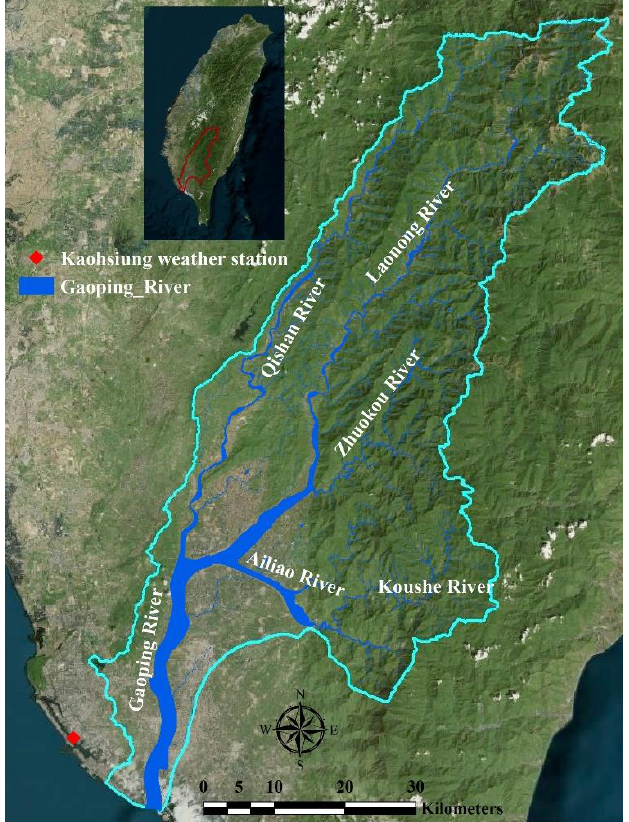
Figure 1. The drainage network in the Gaoping River basin.